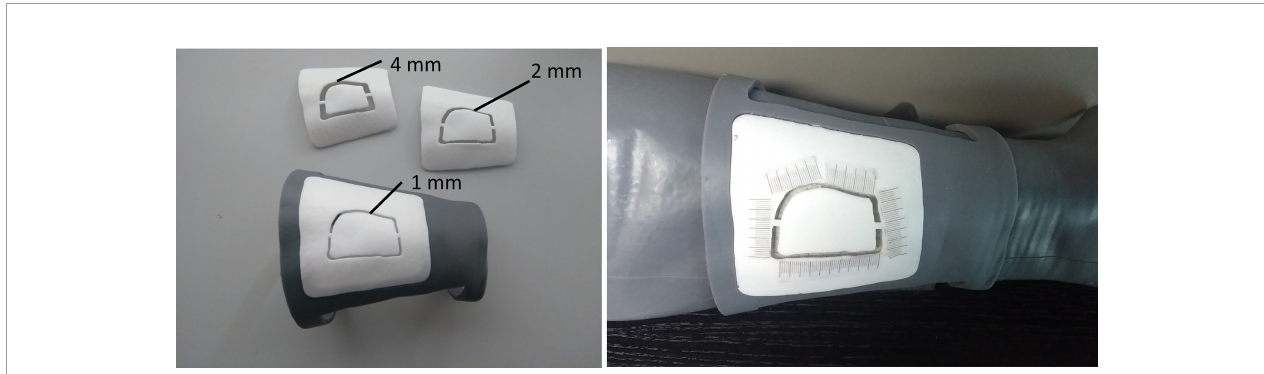
FIGURE 8 | CAD/CAM templates used to evaluate the success rate in performing the AR-guided task, using different levels of accuracy (template “ 1 mm ” , template “ 2 mm ” , template “ 4 mm ”